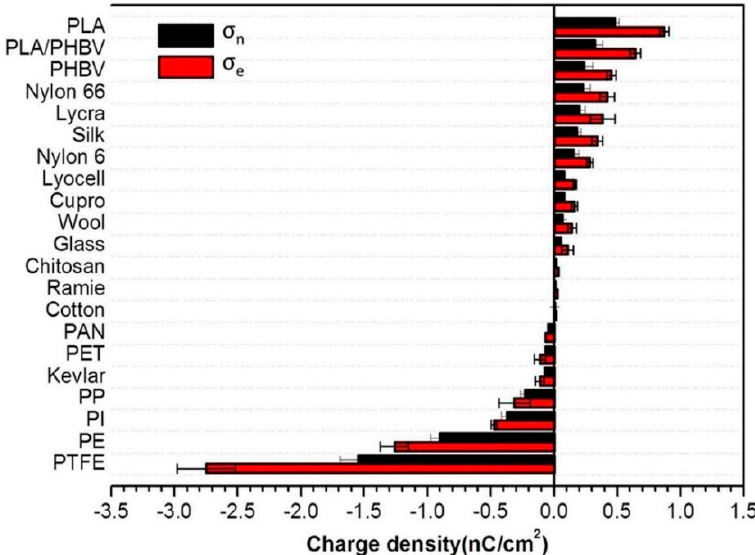
Figure 5. Various positive and negative charge densities for textile fibers [65].